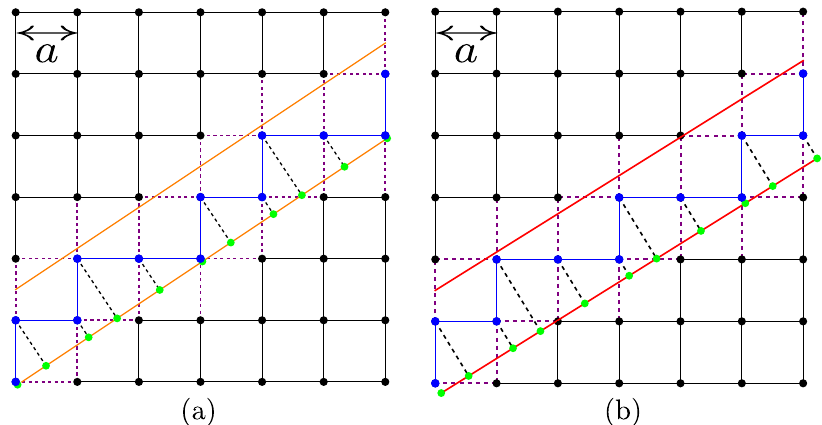
Fig. 1 Construction of a one-dimensional (1D) projected lattice. The projected lattice is constituted by the sites residing within the ( a ) orange and ( b ) red lines, from a parent two-dimensional (2D) square lattice of lattice spacing a . These lines are de fi ned by y i ¼ S ð x (cid:2) ~ x i Þ þ x i for i = u and d , with x u > x d , ~ x u ¼ 1 and ~ x d ¼ 2. Here x measures the horizontal coordinate of lattice sites. In ( a ) S = 2/3 and in ( b ) S = φ − 1 , where φ ¼ ð 1 þ 2/3 is a rational approximant of φ − 1 . When the garnered sites (blue dots) are projected (shown by black dashed lines) onto a 1D chain (green dots), a new lattice periodicity emerges in ( a ), while in ( b ) they constitute a Fibonacci quasicrystal, devoid of periodicity. Thermodynamic limit can be approached by increasing x u for a fi xed x d , which does not alter the periodicity in ( a ) or Fibonacci sequence in ( b ), such that the number of sites within the brane N / L 2 → 0, where L is the linear dimension of the parent square lattice in x and y directions, as both N , L → ∞ . The solid black (blue) lines constitute the hopping matrix elements of H 22 ( H 11 ) and purple dashed lines to H 12 and H 21 appearing in H PTB [Eq. (1)], originating from a parent Hamiltonian containing only nearest- neighbor hopping elements [Eq.